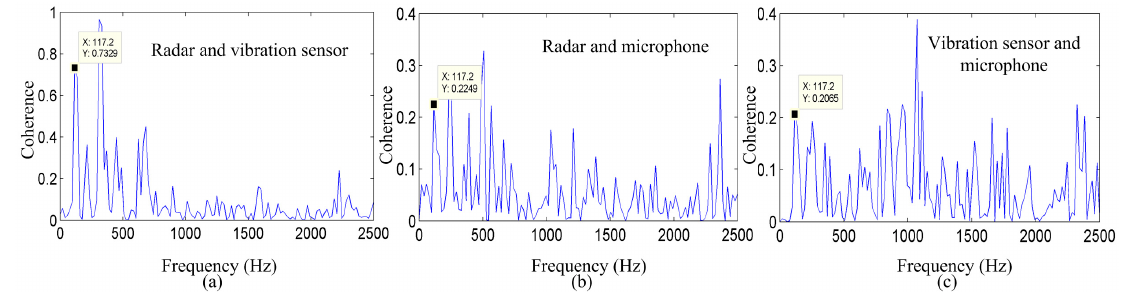
Figure 10. Coherence between the three measurement methods for the spoken word “welcome.” Coherence between the signals detected by the ( a ) radar and vibration sensor; ( b ) radar and microphone system; and ( c ) vibration sensor and microphone system.